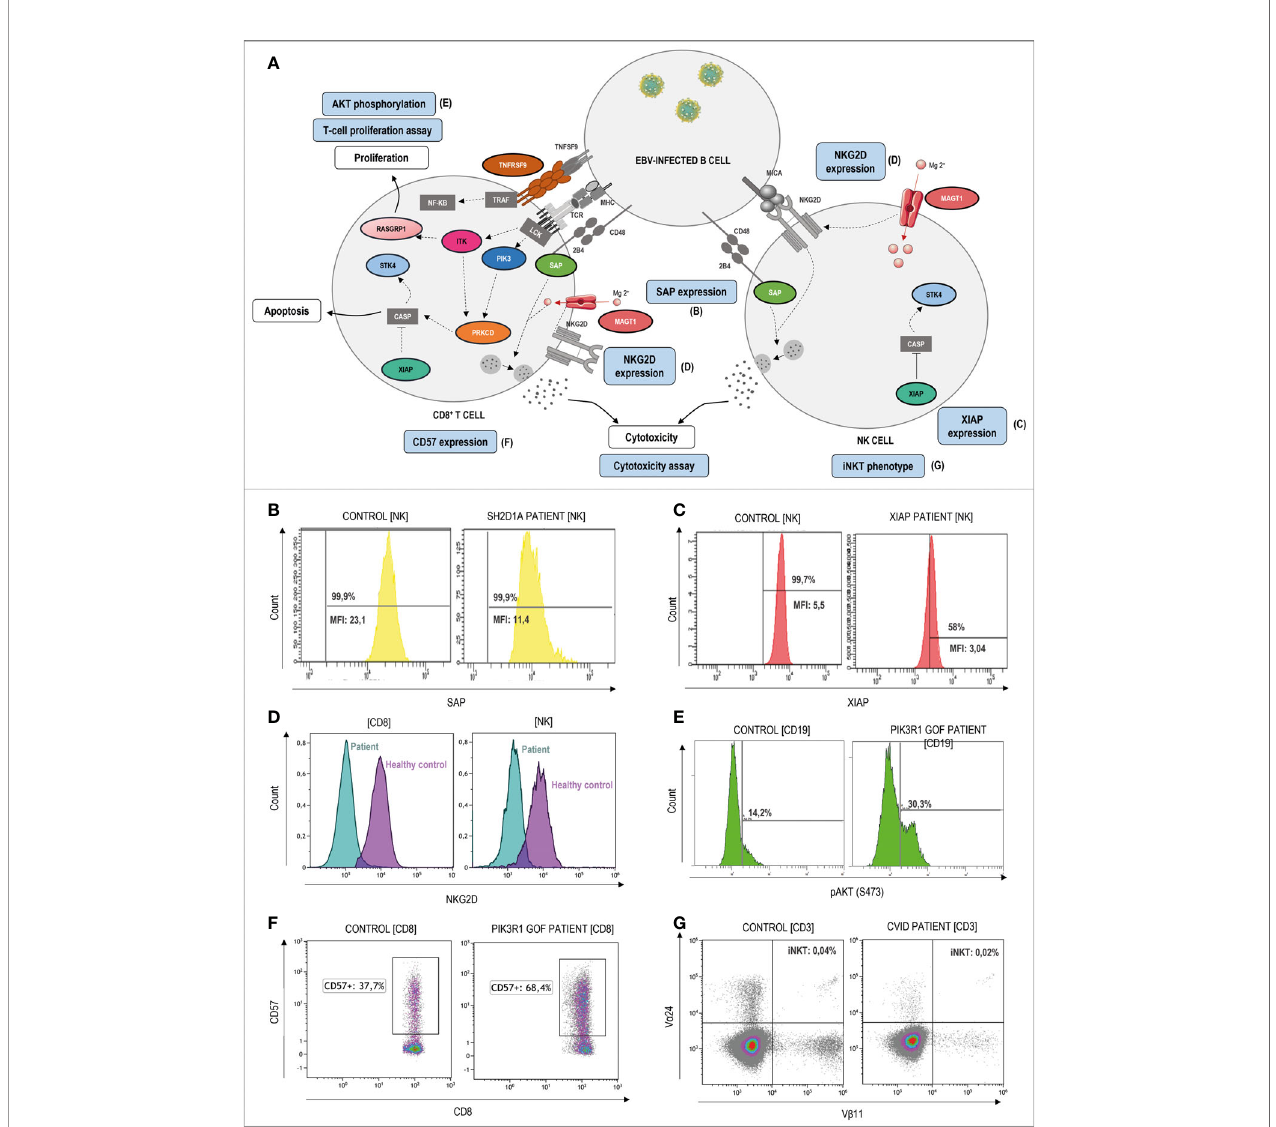
FIGURE 4 | Pathophysiology and functional assays through fl ow cytometry in ALPS-like patients with EBV-susceptibility. (A) Schematic representation of the genetic defects (in color) and pathways identi fi ed in ALPS-like patients predisposing to high susceptibility to Epstein-Barr Virus (EBV)-driven lymphoproliferative disease. Immunologic studies are outlined in blue. The letters in parentheses refer to the functional studies included in fi gure 4. Defects in the control of EBV infection is mainly due to impairment of CD8, NK and NKT cell cytotoxicity (due to SAP, MAGT1 and TNFRSF9 de fi ciencies) and/or EBV-speci fi c T cell proliferation (due to ITK, RASGRP1, TNFRSF9 de fi ciencies, PIK3CD gain of function and PIK3R1 loss of function) or survival (due to XIAP and STK4 de fi ciencies). (B) Decreased but not absent SAP expression in NK-cells of a patient with SAP de fi ciency. MFI: median fl uorescence Intensity. (C) Decreased but not absent XIAP expression in NK-cells of a patient with XIAP de fi ciency. (D) Decreased NKG2D expression both in CD8 T and NK-cells of a MAGT1 patient (blue) in comparison with a healthy control (purple). (E) Hyperactivation of the PI3K-AKT signaling pathway is shown as high levels of AKT phosphorylation in a patient with PIK3R1 defect. (F) Senescence phenotype of CD8+CD57+ T-cells in a PIK3R1 patient. (G) Decreased CD3+V a 24+V b 11+ invariant NKT-cells in a patient with common variable immunode fi ciency and ALPS-like